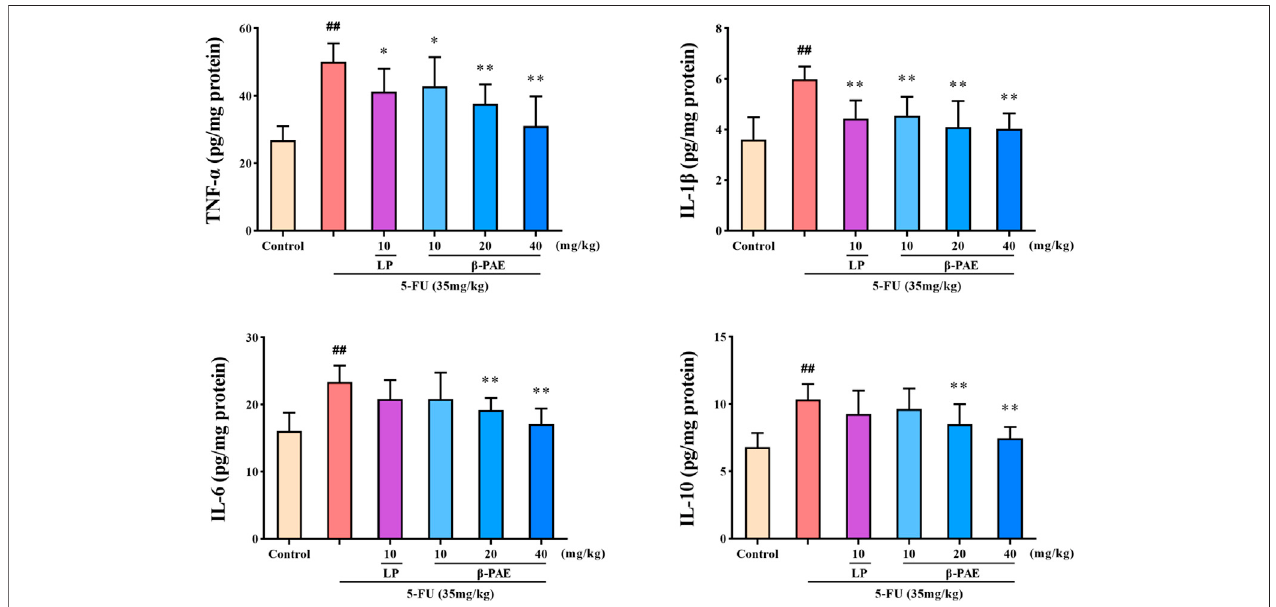
FIGURE6| Effectsof β -PAEonintestinalTNF- α ,IL-1 β ,IL-6andIL-10expression.Dataareshownasmean ± SD( n (cid:2) 8). ## p < 0.01versuscontrolgroup;* p < 0.05, ** p < 0.01 versus 5-FU